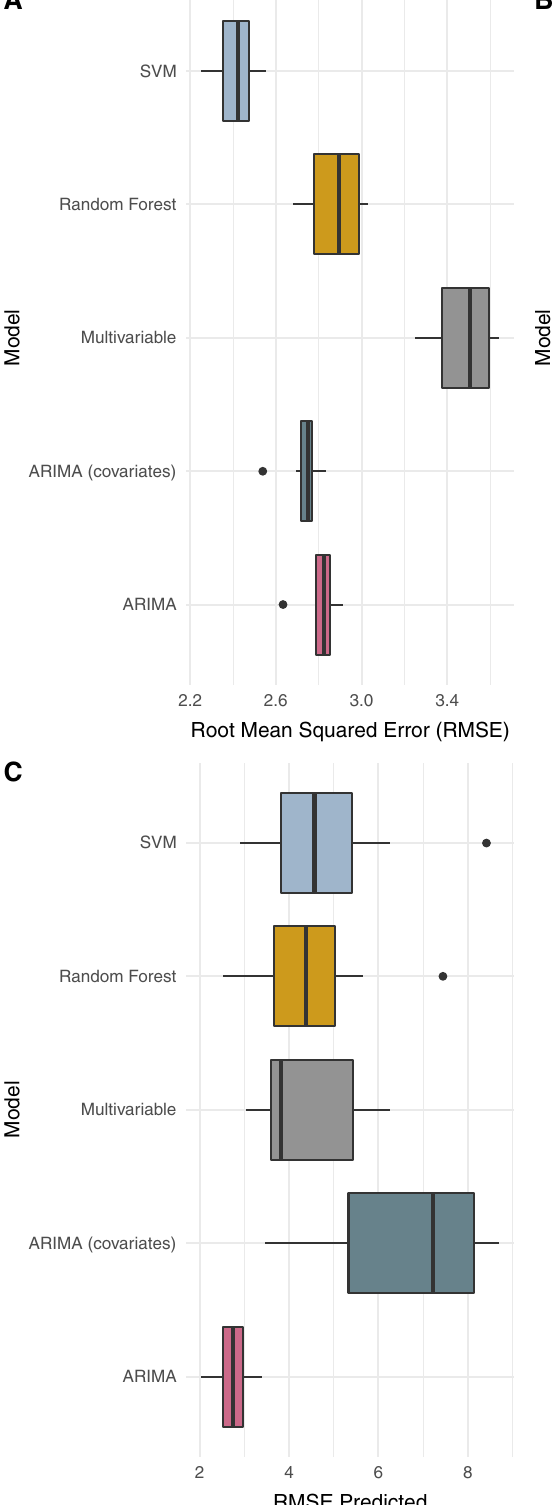
Figure 3. Comparison of models fitted to data for the Littoral region. (A) Root Mean Squared Error (RMSE) of fitted values, (B) model R-squared and (C) RMSE of out-of-sample predictions. The models include Support Vector Machines Regression (SVM), Random Forest Regression, Multivariable linear regression, and ARIMA with [i.e., ARIMA (covariates)] and without (i.e., ARIMA) search data as explanatory